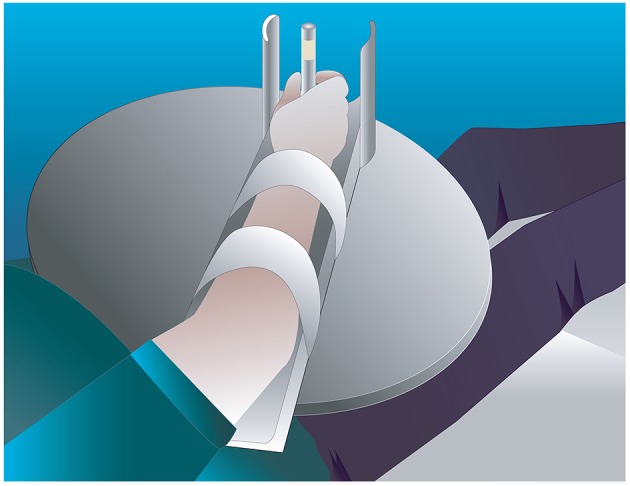
Task set-up for the splint condition.